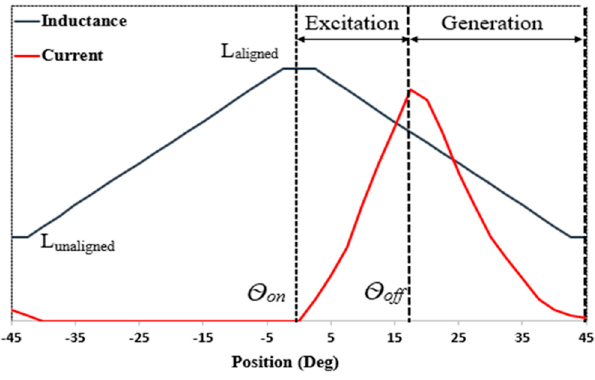
Figure 2. SRM inductance profile.